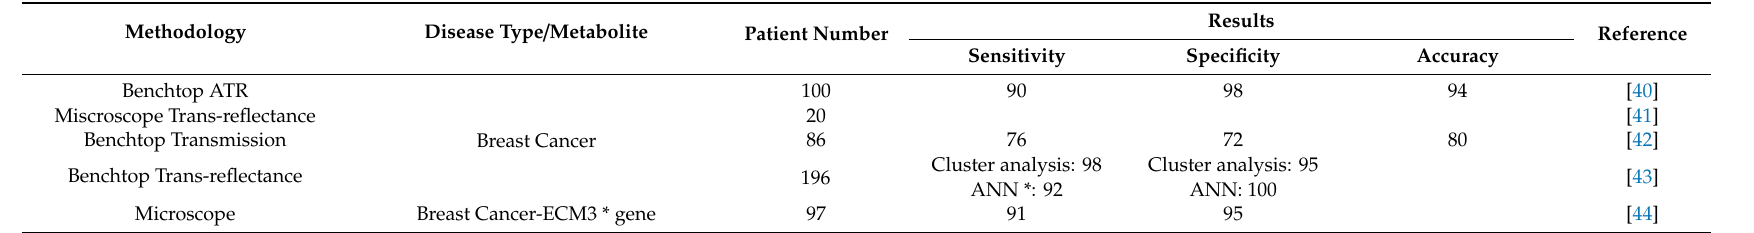
Table 2. Overview of clinical studies performed by using FT-IR spectroscopy as a diagnosis tool in vivo in